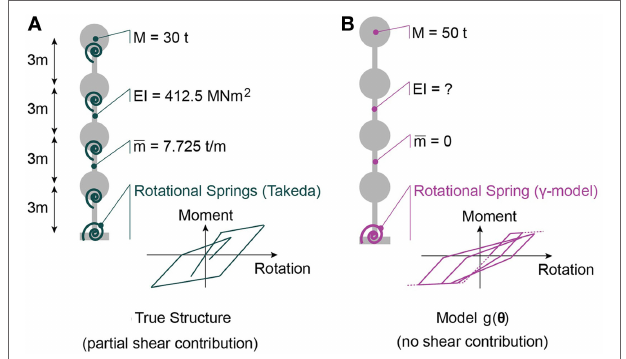
FIGURE 2 | Description of lumped mass models representing the baseline (true) structure (A) as well as model g(.) for which parameters θ are identified (B) . Identification is performed on states before and after main earthquake. Behavior during aftershock is predicted.